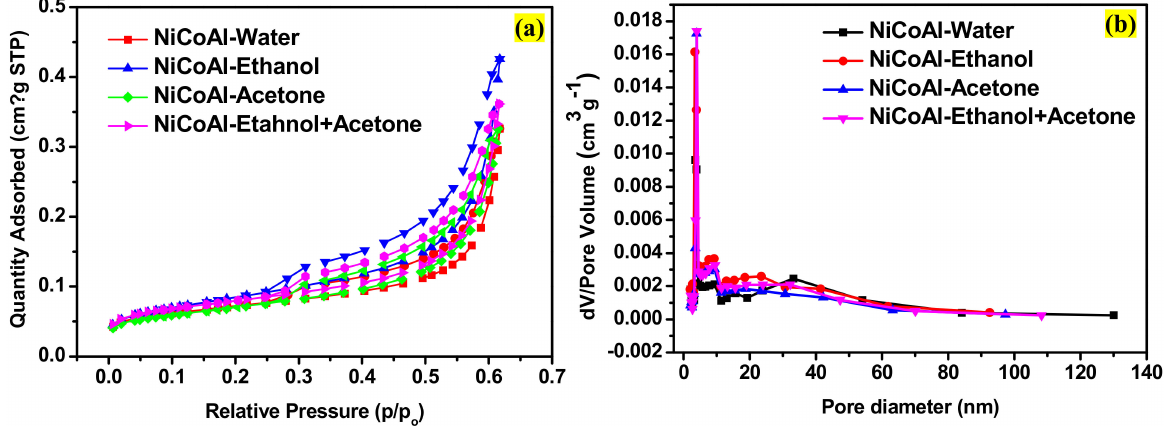
Figure 4. ( a ) N2-sorption isotherms and ( b ) pore size distribution for NiCoAl-Water, NiCoAl-Ethanol, NiCoAl-Acetone, and NiCoAl-Ethanol +